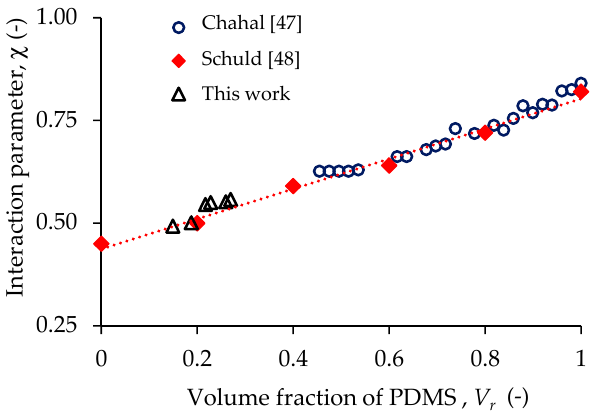
Figure 15. Computed interaction parameter values from Equation (3), compared to those reported by Chahal [47] and by Schuld [48].